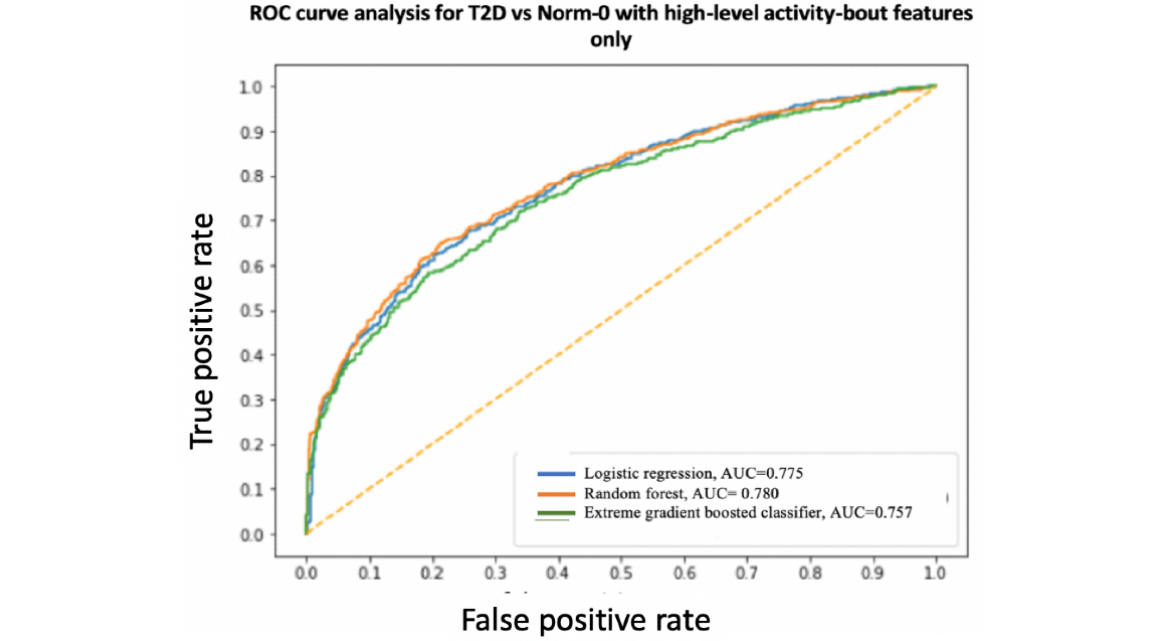
Figure 8. Receiver operating characteristic curve and area under the receiver operating characteristic curve for type 2 diabetes vs Norm-0: High-level activity bout features only. AUC: area under the receiver operating characteristic curve; ROC: receiver operating characteristic curve; T2D: type 2